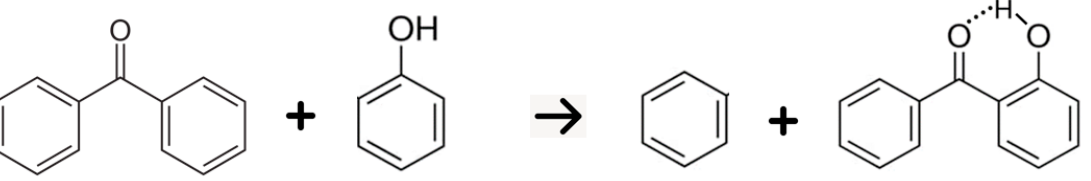
Figure 10. Determination of the intra-molecular hydrogen bonding strength in 2-hydroxy-benzophenone using the “ortho-para” method. The blue arrow represents the additional para C = O ( C 6 H 5 ) − OH = − 3.4 kJ · mol − 1 , that should be subtracted from the enthalpy of this reaction to attribute the corrected result to intra ‐ HB strength.